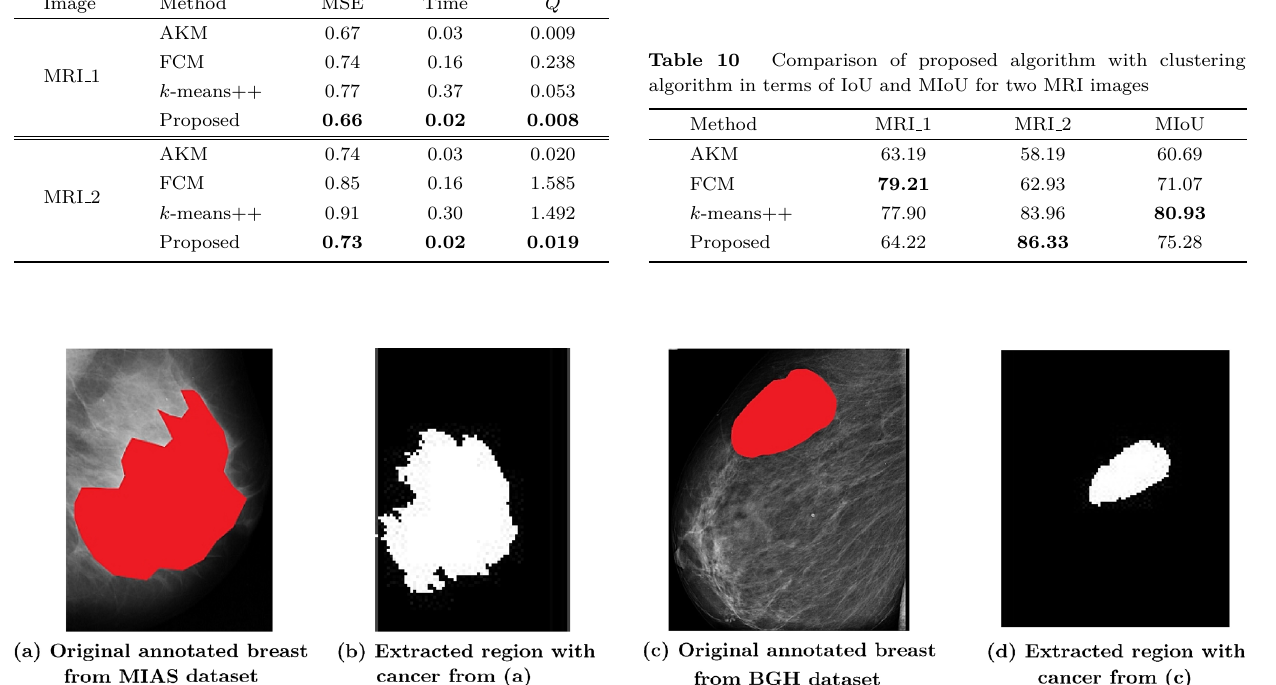
Table 9 Comparison of proposed algorithm with clustering image segmentation algorithm in terms of MSE, Time, and Q for two MRI images Image